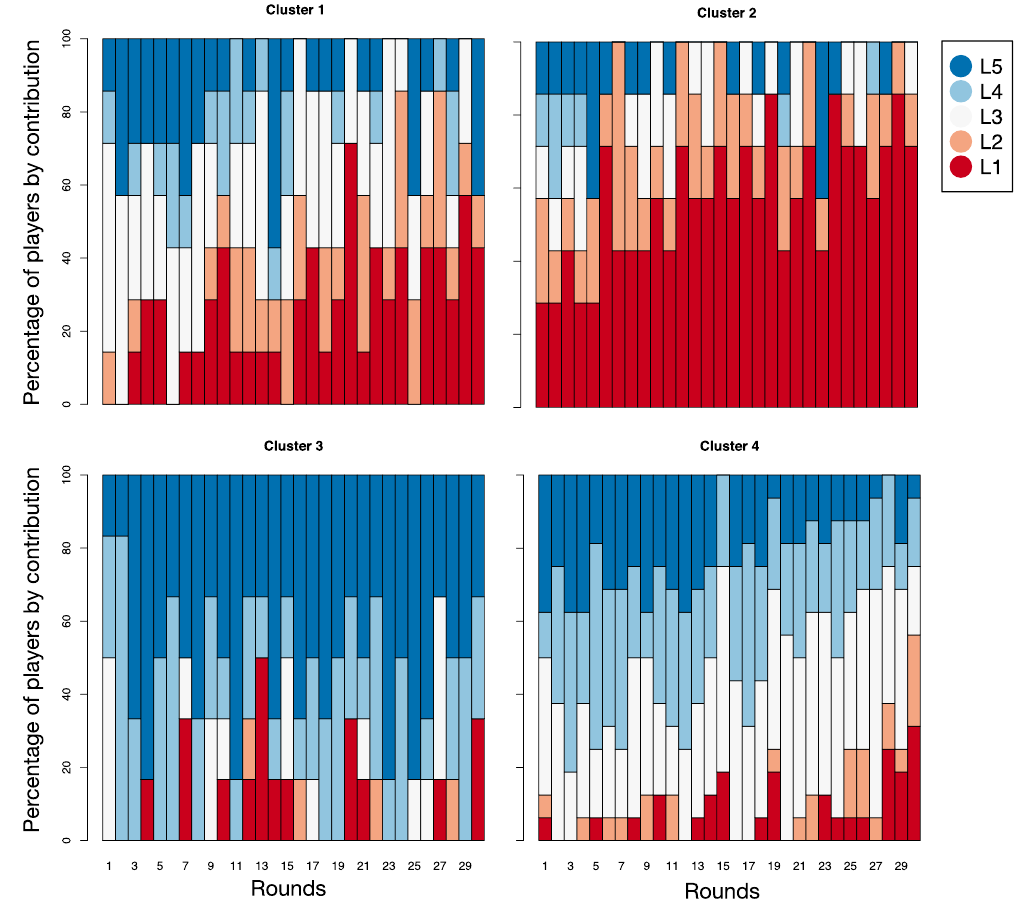
Figure 3. Percentage of players by contribution level in each cluster in the homogeneous treatments. The participants are clustered according to the similarity of their sequence of contribution in the rounds (see the Methods section). There are four clusters of sizes 7, 7, 6 and 16. The only treatment exhibiting significant clustering is the homogeneous treatment, indicating that individual behaviour in the heterogeneous treatment is more diverse. The levels L 1 , L 2 , L 3 , L 4 , and L 5 are defined in the main